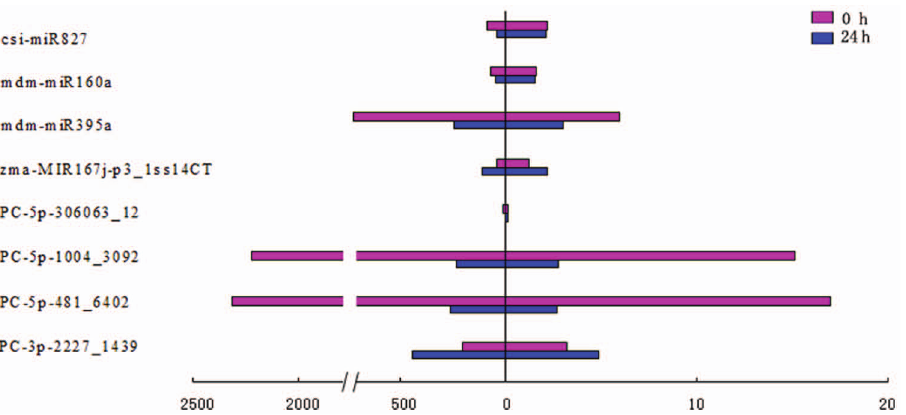
Figure 2. Expression analysis of miRNAs in strawberry fruit stored at 20 6 C for 0 and 24 h by qRT-PCR. The amount of expression was normalized by the level of actin 7 in qRT-PCR. All reactions of qRT-PCR were repeated three times for each sample. Left indicates the miRNA relative expression generated from the high-throughput sequencing; Right indicates the miRNA relative expression tested by qRT-PCR.